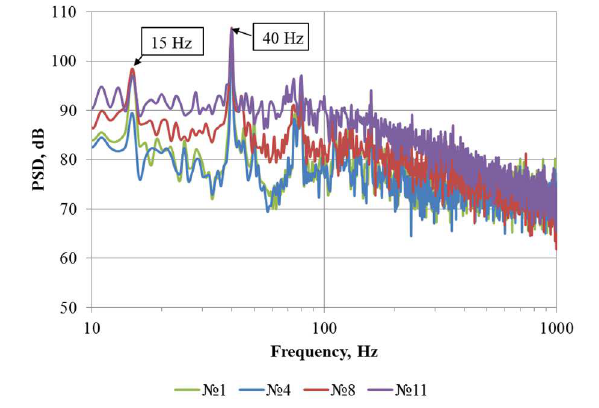
Fig. 9. Power spectral density at the control point.